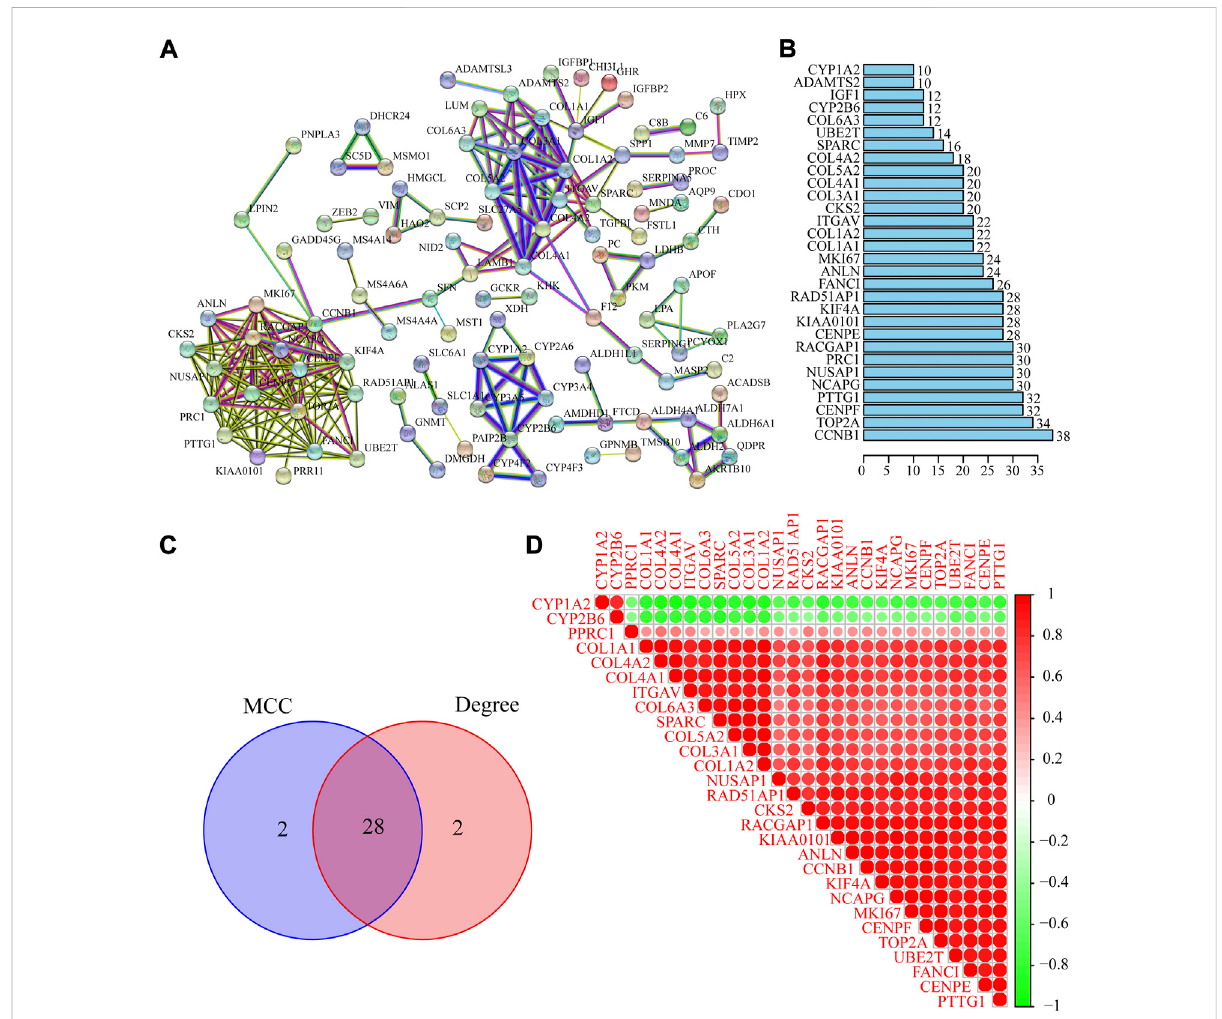
FIGURE 4 Identi fi cation and analysis of the PPI network of DEGs and hub genes. (A) PPI network was constructed using STRING database. (B) Top thirty gene in the PPI network. (C) Venn diagram to identify intersected hub genes screened by the MCC and Degree methods. (D) Pearson ’ s correlation analysis of 28 hub genes.